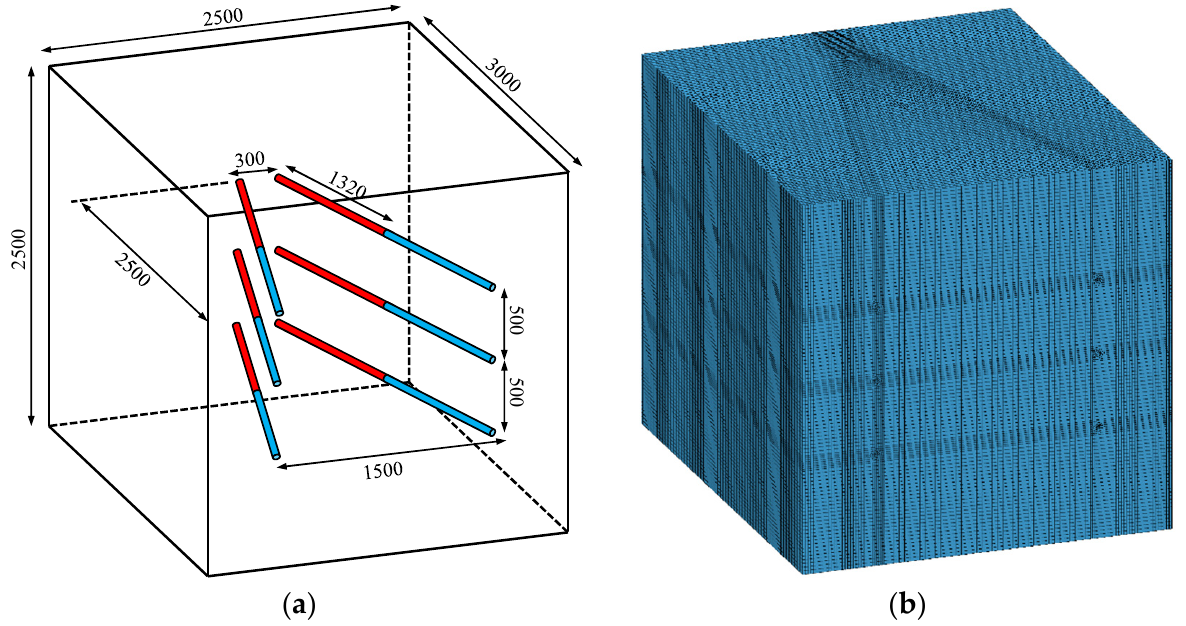
Figure 4. Numerical model and mesh division. ( a ) Numerical model of cutting blasting (unit: mm). ( b ) Mesh division of rock model.